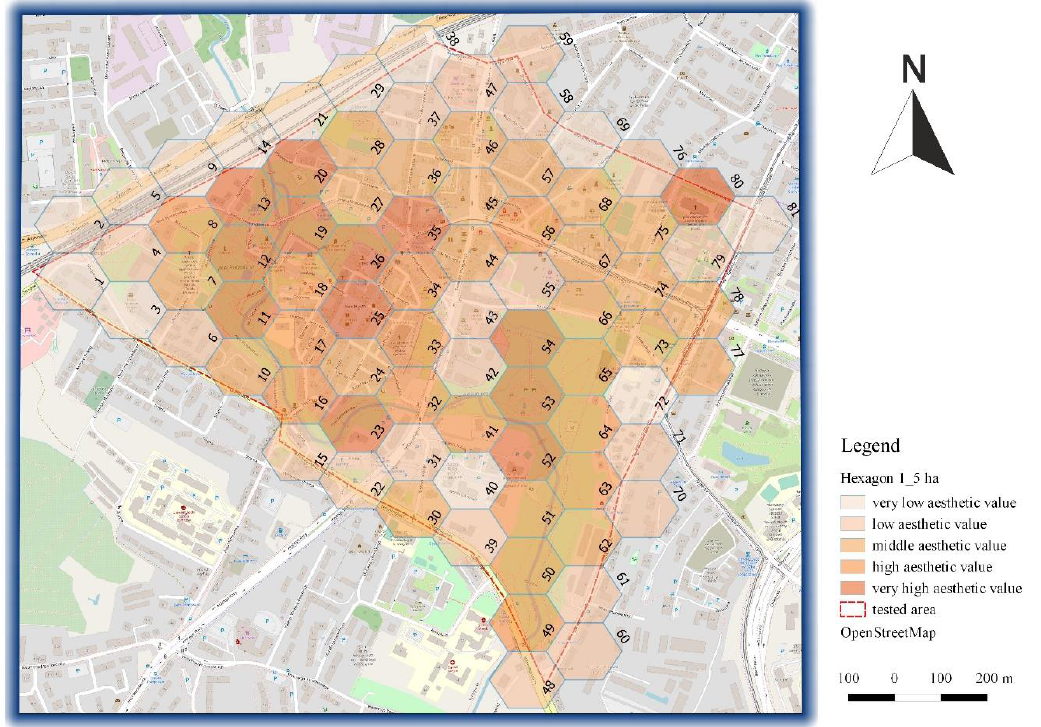
Figure 9. The area of analysis. Hexbin map of aesthetic value needed for network modeling. Source: Own analysis in QGis and based on Open Street Map data.